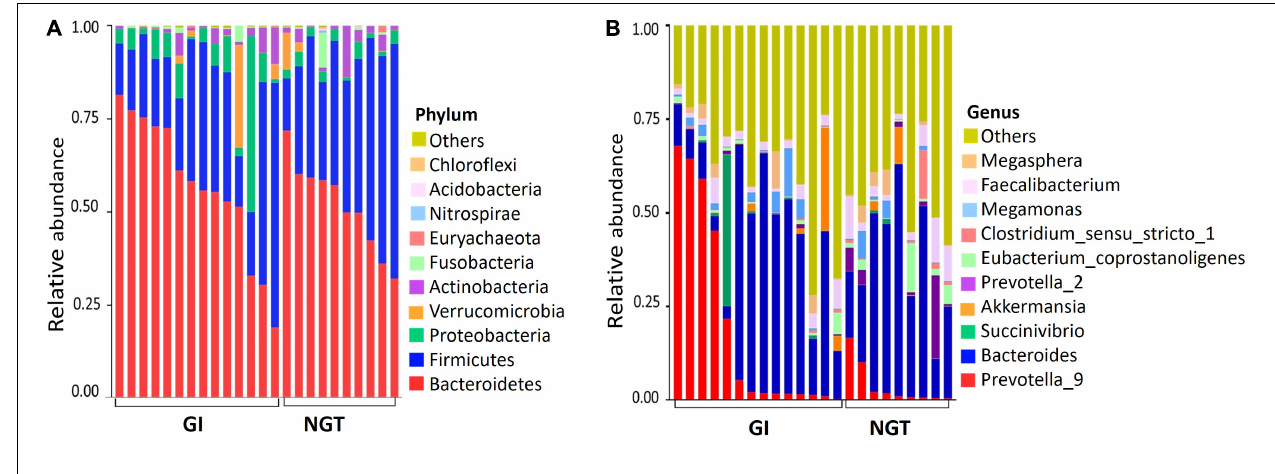
FIGURE 1 | (A) Top 10 relative abundance of the gut microbiota at the phylum level between GI and NGT groups. (B) Top 10 relative abundance of the gut microbiota at the genus level between GI and NGT groups. Each stacked bar resembles the relative abundance of the gut microbiota of one post-GDM woman. GI, glucose intolerance; NGT, normal glucose